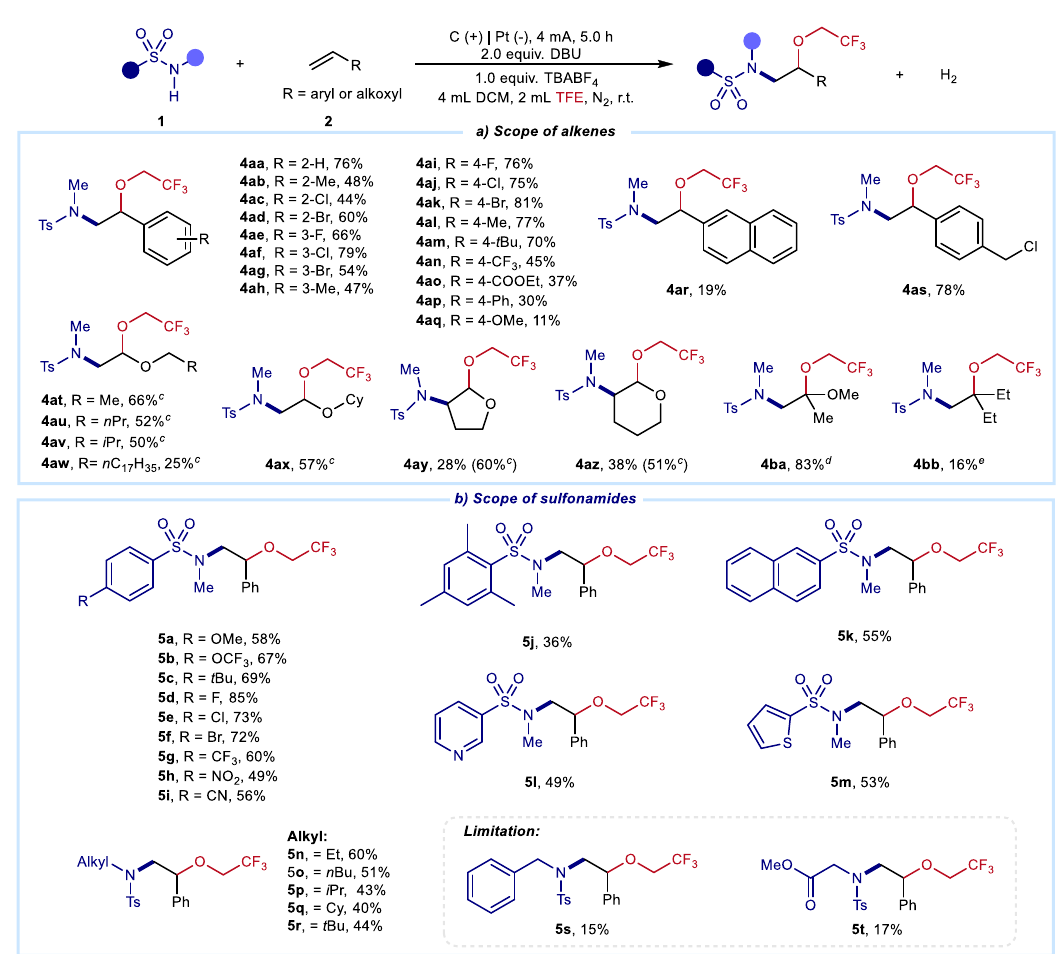
Fig. 2| Scopeofsubstrates.a Scopeofalkenes. Reaction conditions:graphiterod anode ( Φ 6mm), Pt plate cathode (15mm×15mm×0.3mm), constant current= 4mA, sulfonamides (0.3mmol, 1 equiv.), alkenes (0.9mmol, 3 equiv.), DBU (0.6mmol), TBABF 4 (0.3mmol), DCM/TFE (4/2mL), r.t., 5h, undivided cell under